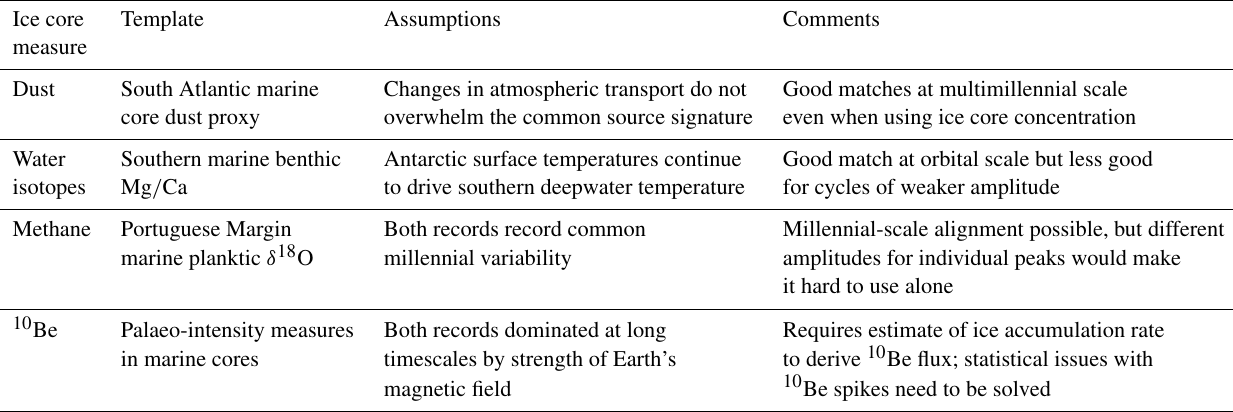
Table 1. Characteristics of possible template matching methods for a 1.5Myr ice core. Ice